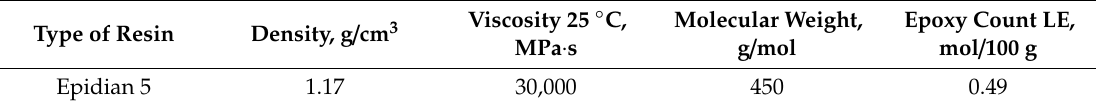
Table 1. The physico-chemical properties of Epidian 5 resin [29].